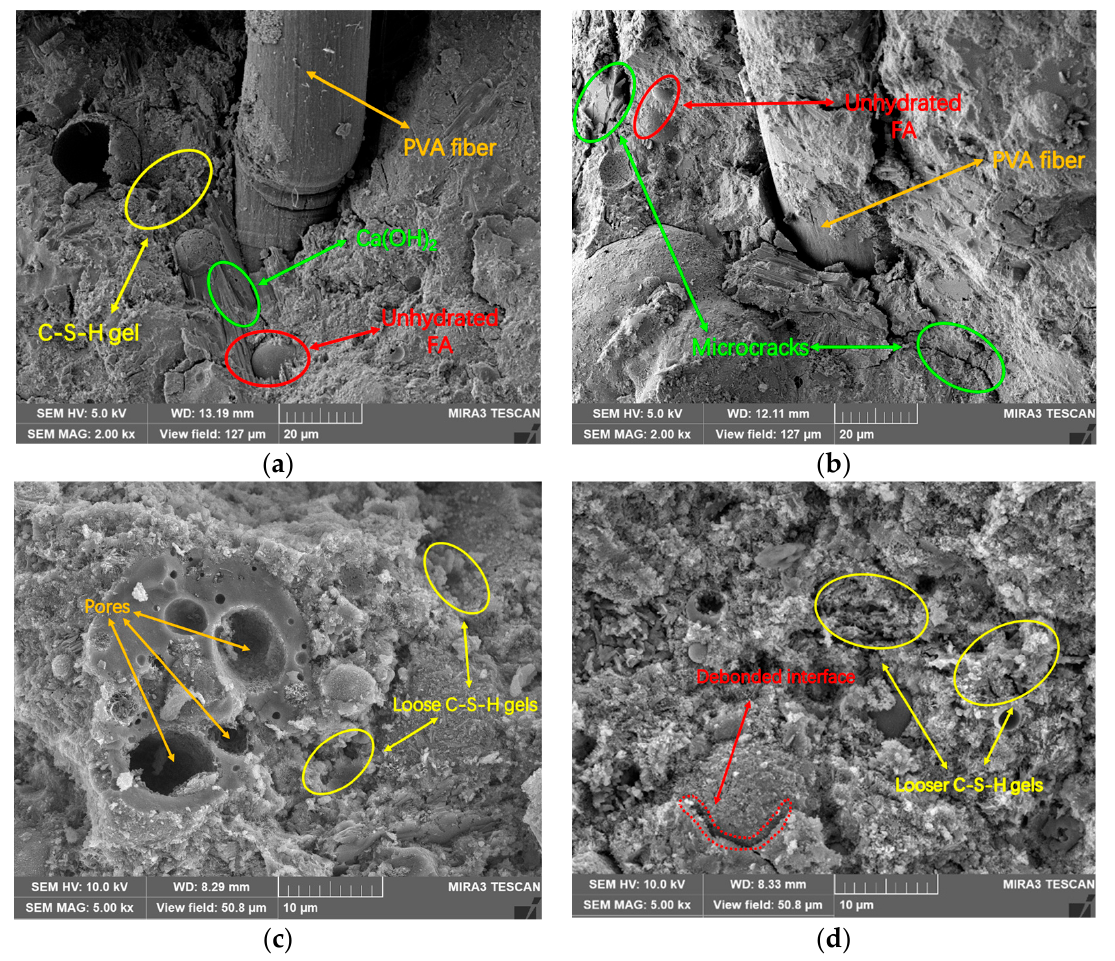
Figure 12. SEM micrographs of PVA-FRCC specimens subjected to different temperatures. ( a ) 25 °C, ( b ) 200 °C, ( c ) 400 °C, and ( d ) 600 °C.